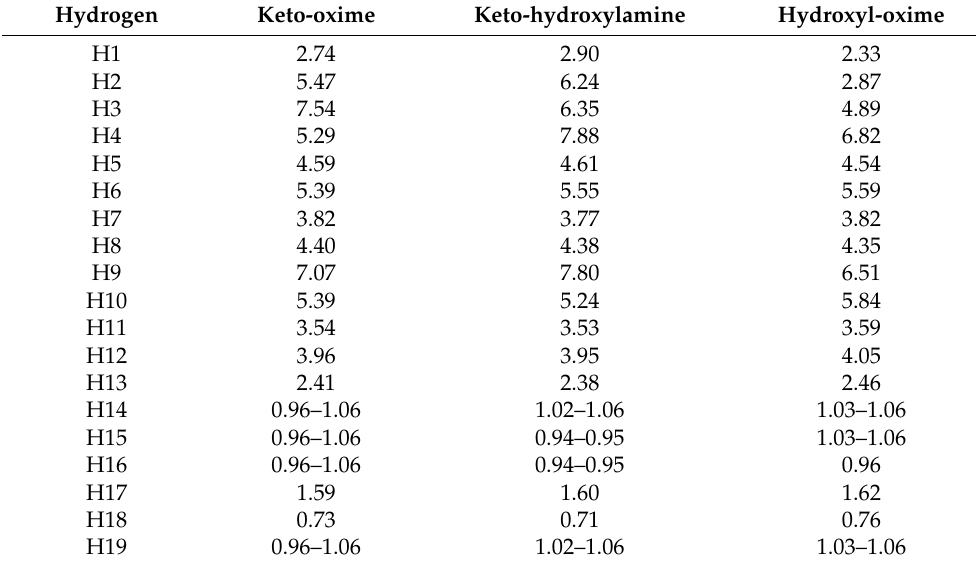
Table 7. Signals for the calculated 1 H NMR spectra of the ground states of the optimized structures of the keto-oxime, keto-hydroxylamine, and hydroxyl-oxime tautomers of molnupiravir, obtained by using the DFT/GIAO/B3LYP/6-311++G(2d,p) method (see Figure 3 for atoms labelling). Hydrogen